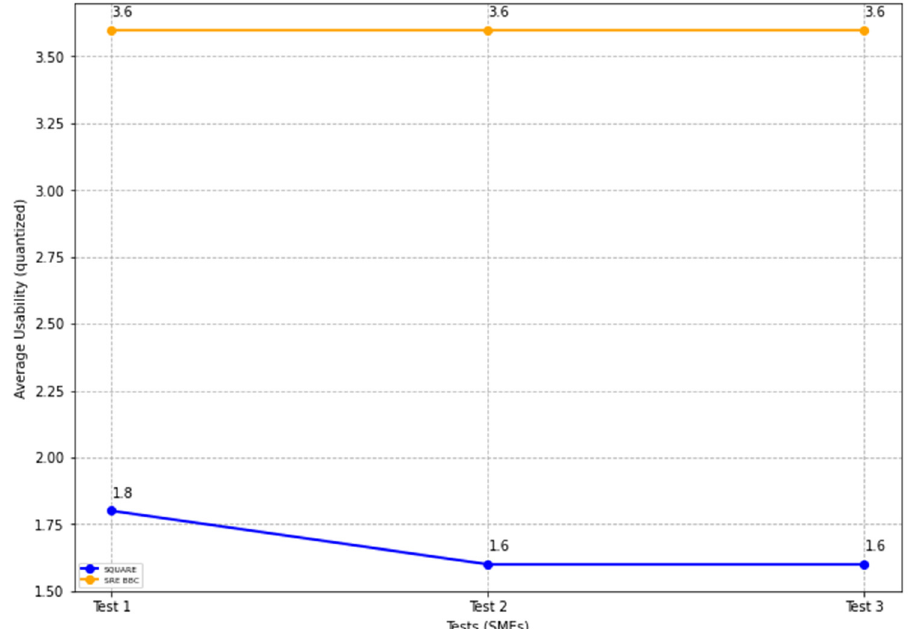
Figure 17. The comparison of quantified usability level score for SQUARE and SRE_BBC (Feasibility Study).